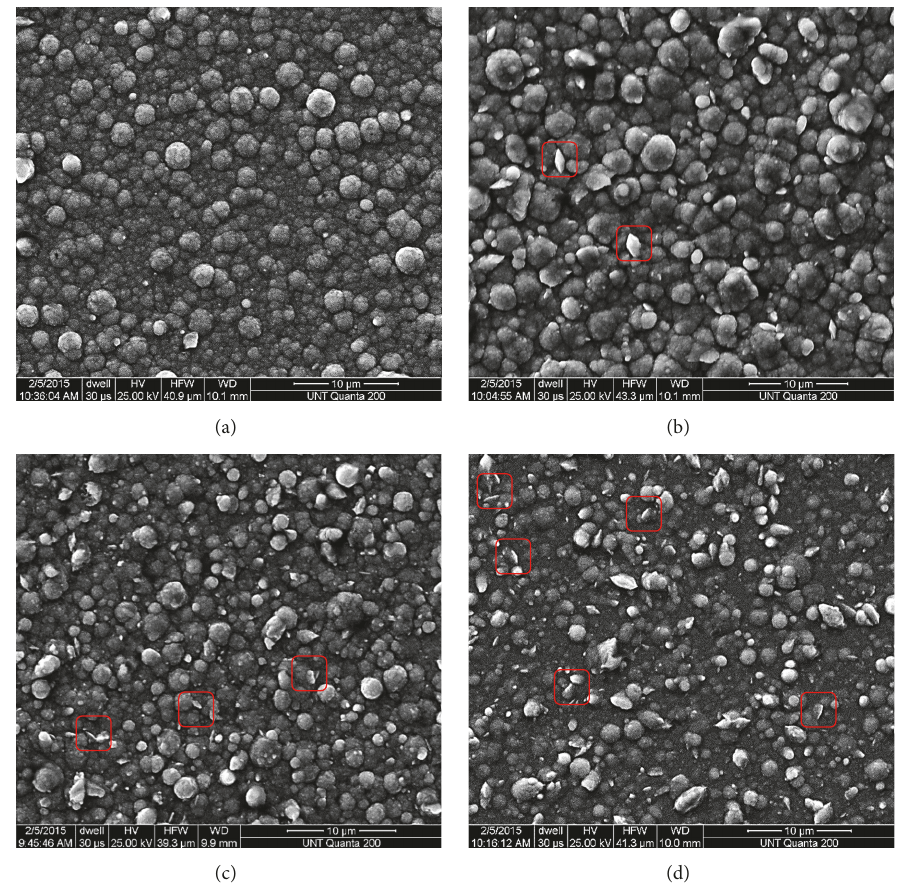
Figure 4: SEM surface micrographs of (a) 90-10 Cu-Ni, (b) 90-10 Cu-Ni-0.05% Mt, (c) 90-10 Cu-Ni-0.10% Mt, and (d) 90-10 Cu-Ni-0.15% Mt. Scale is 10 𝜇 m. Red squares show examples of Mt platelets. Table 4: Energy dispersion spectroscopy data of the pure 90-10 Cu-Ni and Cu-Ni-Mt composite coatings. Coatings Copper (%) Nickel (%) Silicon (%) Aluminum (%) Cu-Ni 89.65 10.35 --- --- Cu-Ni-0.05% Mt 86.05 Cu-Ni-0.10% Mt